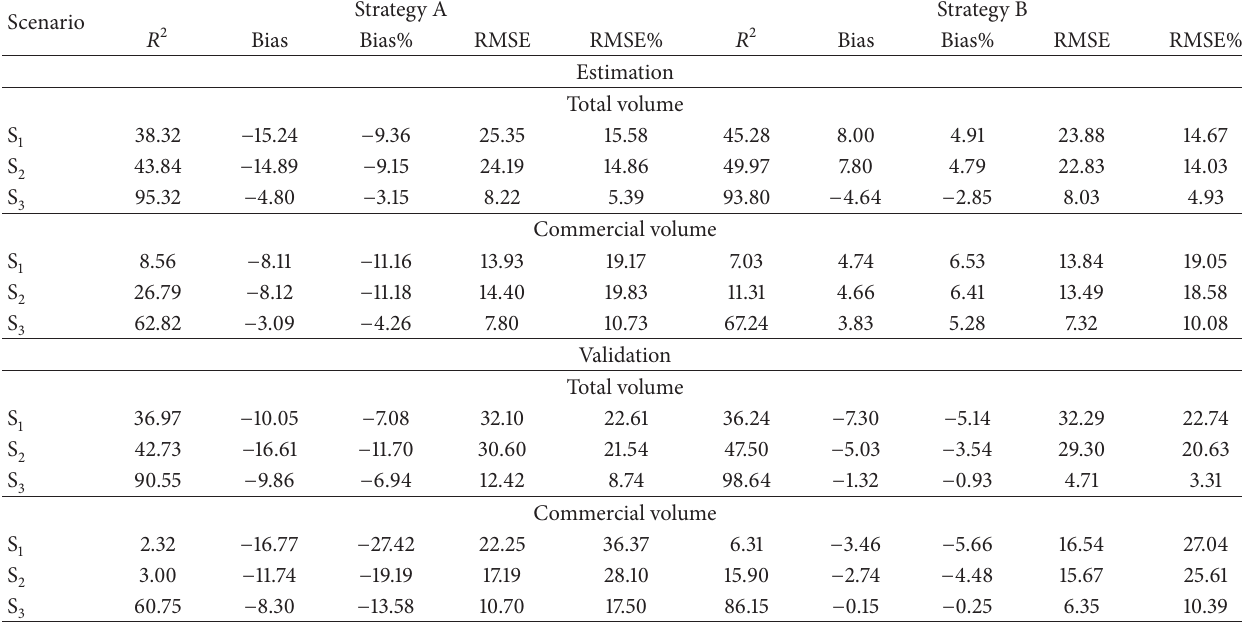
Table 3: Statistics obtained for the scenarios evaluated by considering results of estimation and validation for Strategies A and